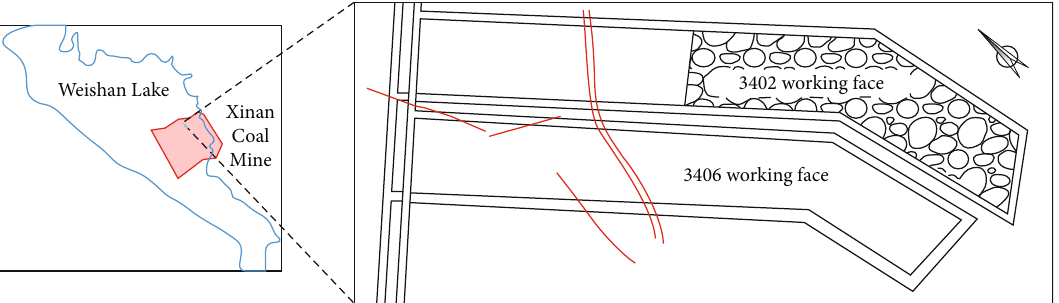
Figure 1: Position map of 3402 working face.